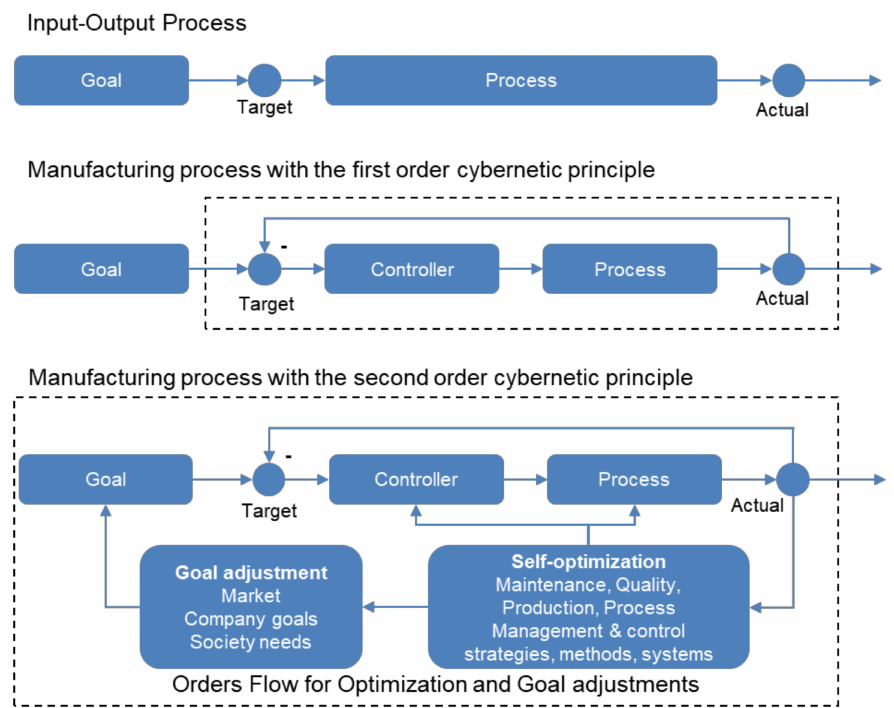
Figure 1. Manufacturing process for Industry 4.0: from input–output to second-order cybernetics (own elaboration based on [33]).